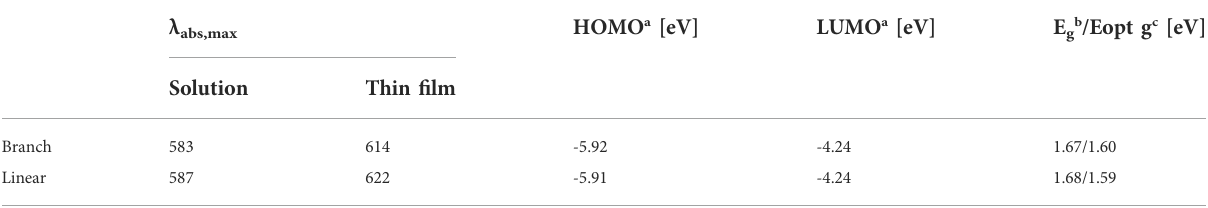
TABLE 1 Optical and electrochemical properties of branch and